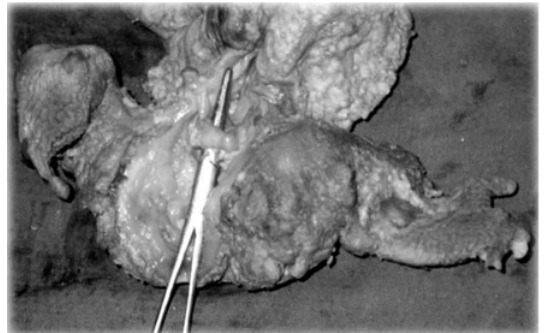
FIGURE 4. Showing ventral aspect of fetus-in-fetu, forceps showing intestinal